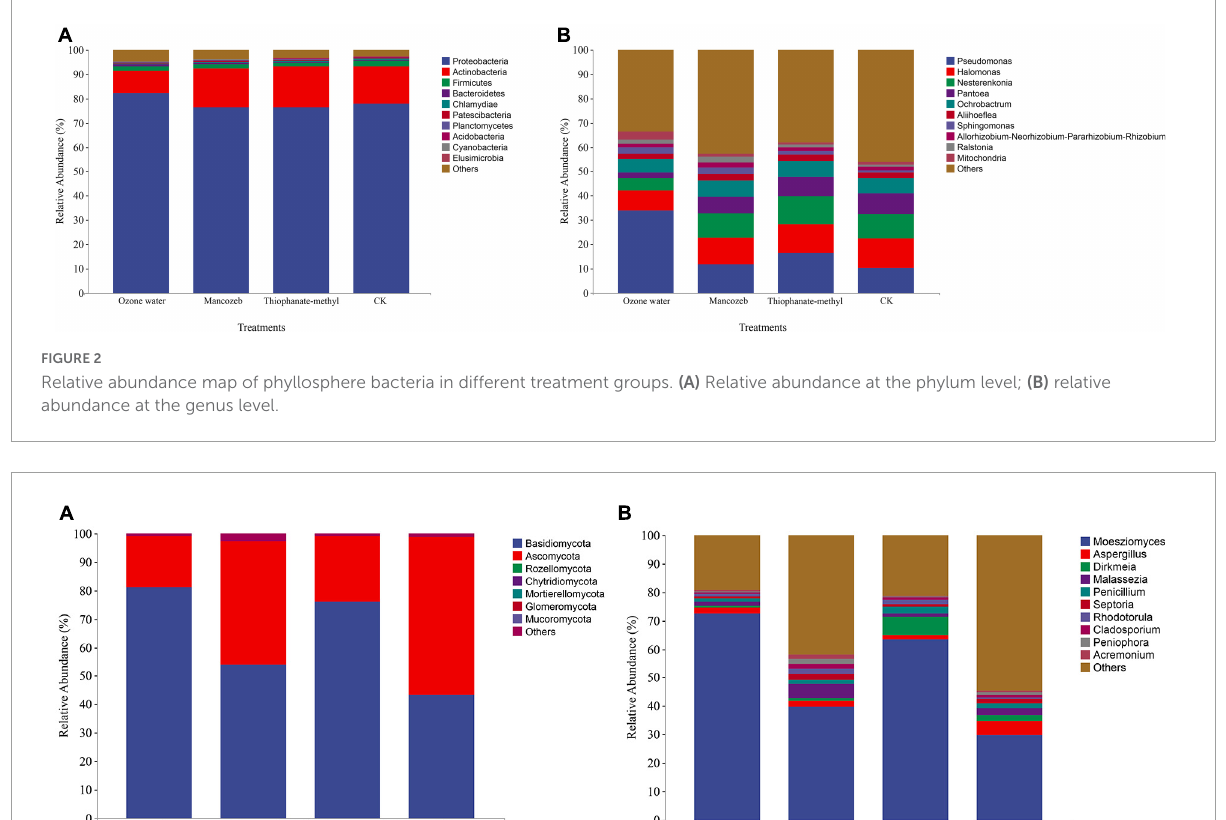
The fungal composition among the treatment groups was further analyzed at the genus level. The results are shown in Figure 3B . Moesziomyces , Aspergillus , Dirkmeia , Malassezia , and Penicillium were the top five genera in relative abundance in each group. The relative abundance of Moesziomyces